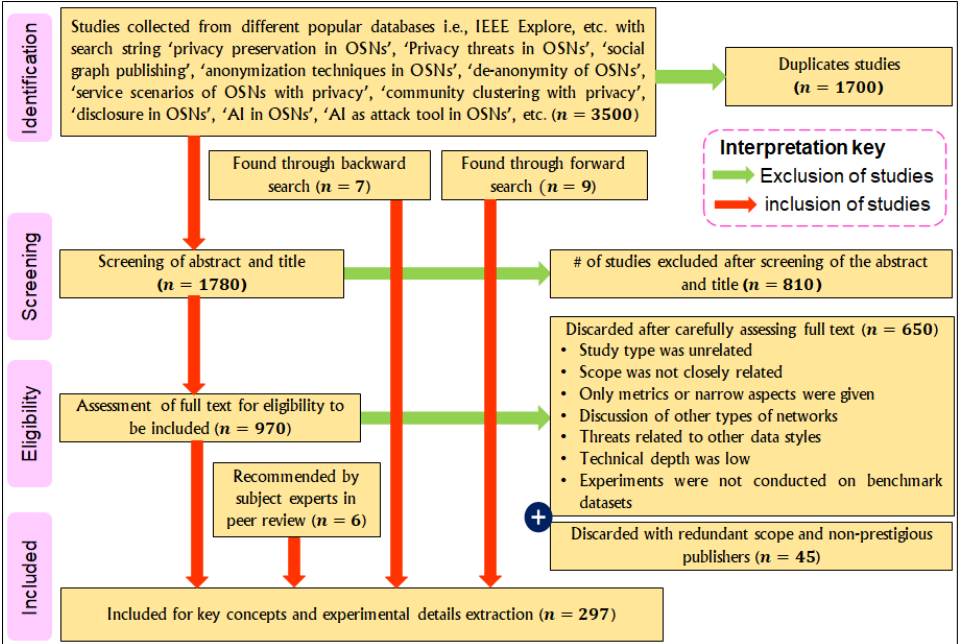
Figure 4. Flow diagram demonstrating the SOTA article selection process for this systematic review.